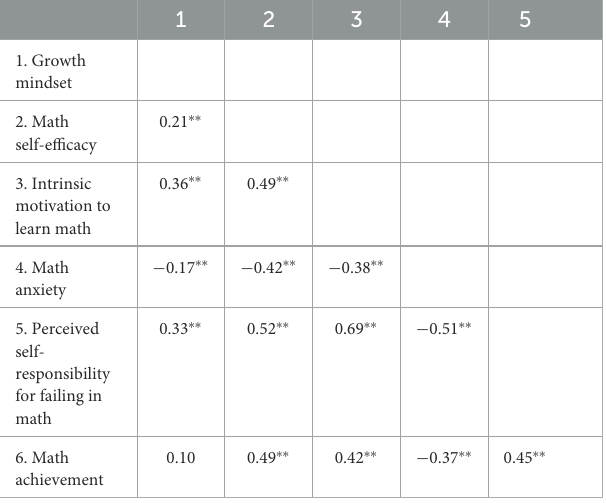
TABLE 2 Summary of correlation